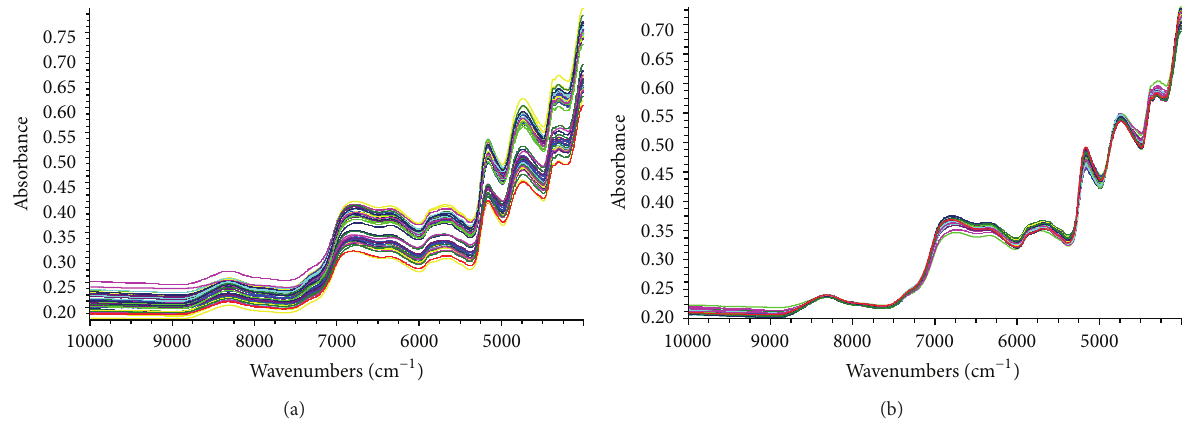
Figure 2: NIR spectra of ginseng samples obtained from original data (a) and MSC processing (b).